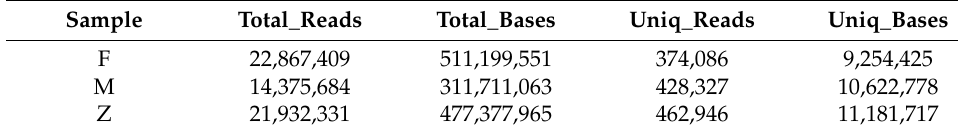
Table 3. The small RNA data statistics of three samples (F, M, Z).